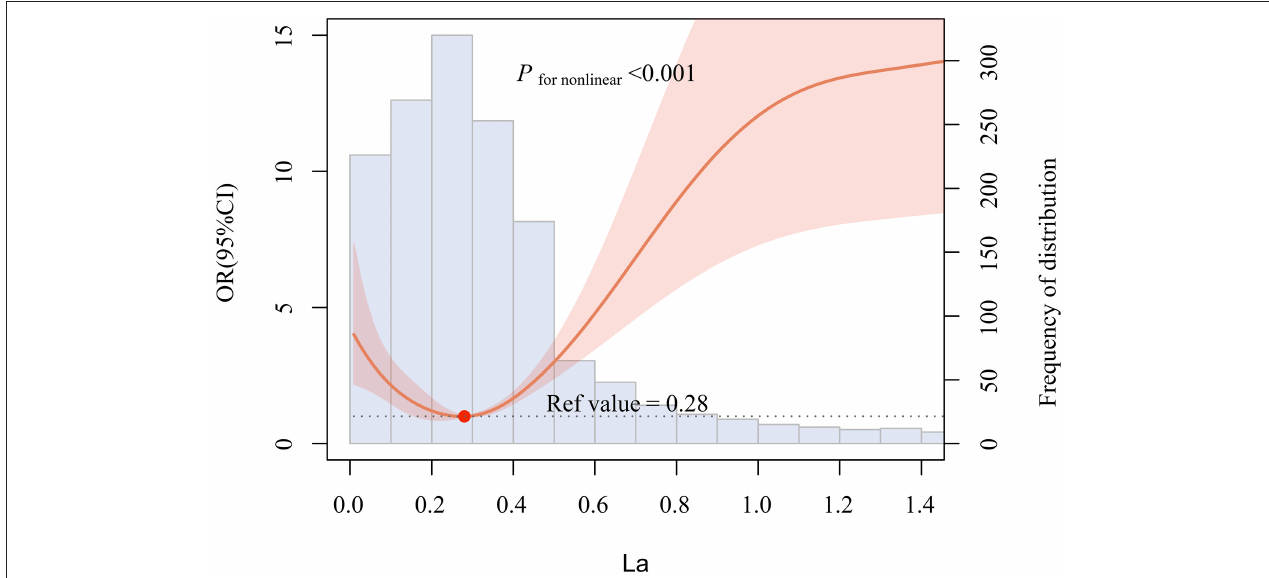
FIGURE 2 | Multivariable-adjusted restricted cubic splines (RCS) according to levels of La on a continuous scale. Solid red lines are multivariable-adjusted odd ratios, with red shading indicating 95% confidence intervals derived from restricted cubic spline regressions with five knots. Reference lines for no association are indicated by the dash lines at an odd ratio of 1.0. The blue regions represent the histogram of the distribution of La. And the solid red dot indicates the concentration of La with the lowest risk of oral cancer. Analyses were adjusted for age, gender, occupation, education level, BMI, residence, family history of cancer, smoking, alcohol and tea drinking, as well as intake frequency of red meat, fish, seafood, vegetables, and